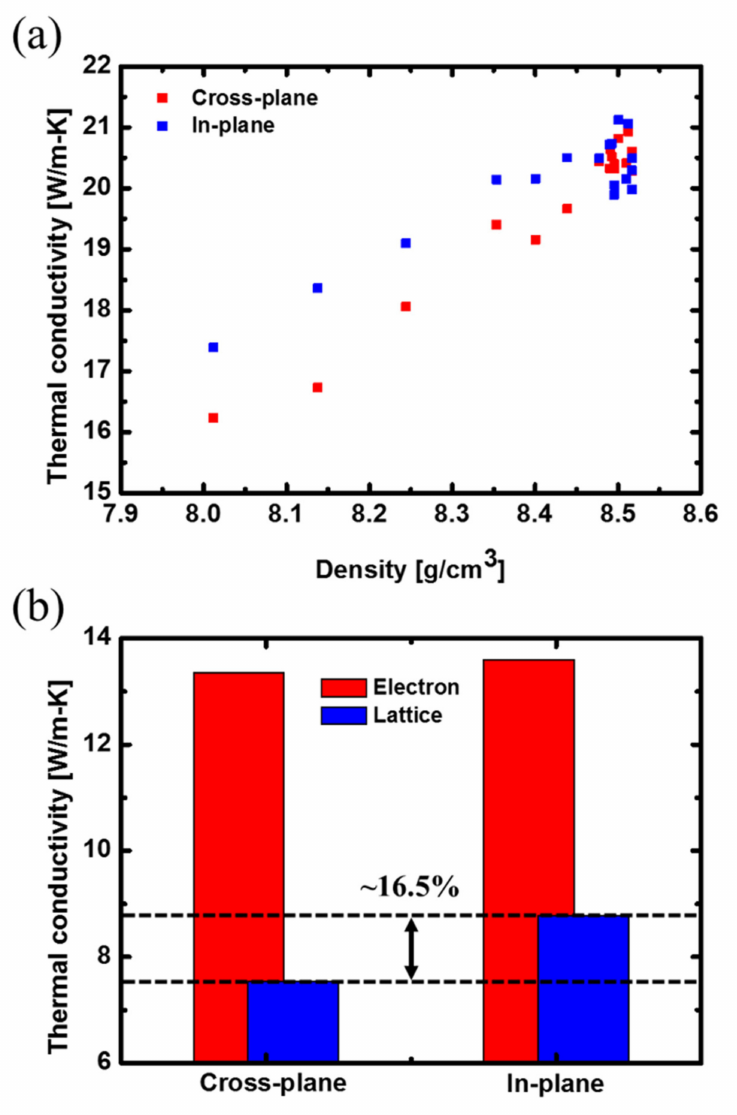
Figure 5. ( a ) Dependence of thermal conductivity in the cross-plane and in-plane directions on density and ( b ) electronic and lattice contributions to cross-plane and in-plane thermal